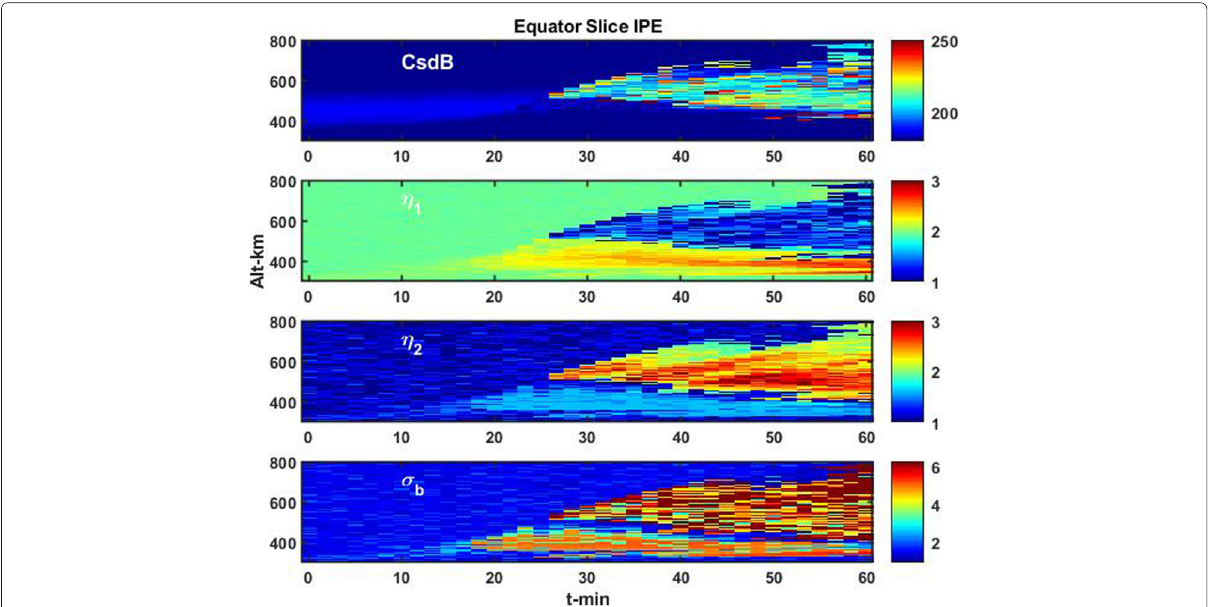
Fig. 8 MLE-IPE SDF parameter estimates from equatorial slice plane realizations at 100 s, where σ b = 2 π/ q